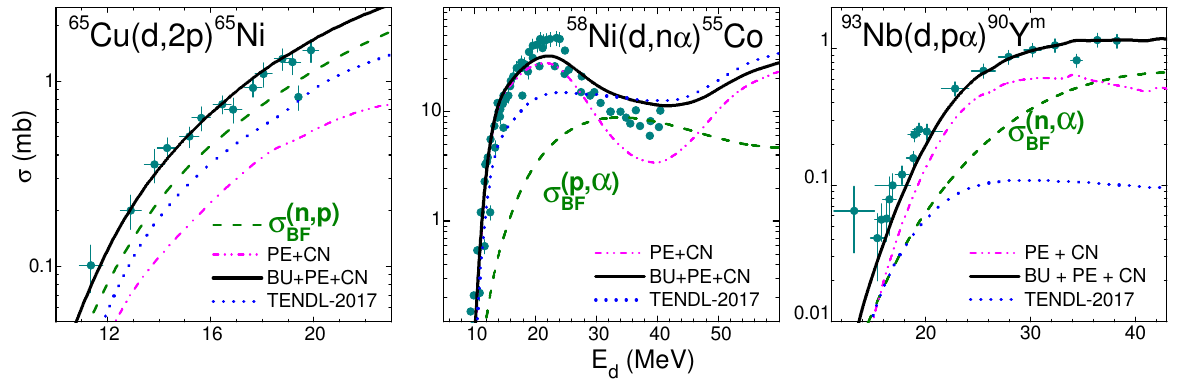
Figure 2. Comparison of measured deuteron activation cross sections [16], the TENDL-2017 evaluations (dotted curves) [11], and the model calculations (solid curves) [3, 4] taking into account the BF (dashed curves) and PE + CN contributions (dash-dot-dotted curves).